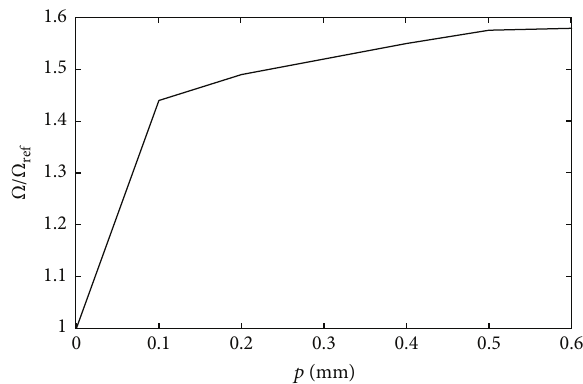
Figure 3: Relative beam coverage solid angle comparison for − 3dB level for the reference antenna ( 𝑝 = 0 mm) and for the reconfig- urable antenna with different shorting pins distances from the antenna